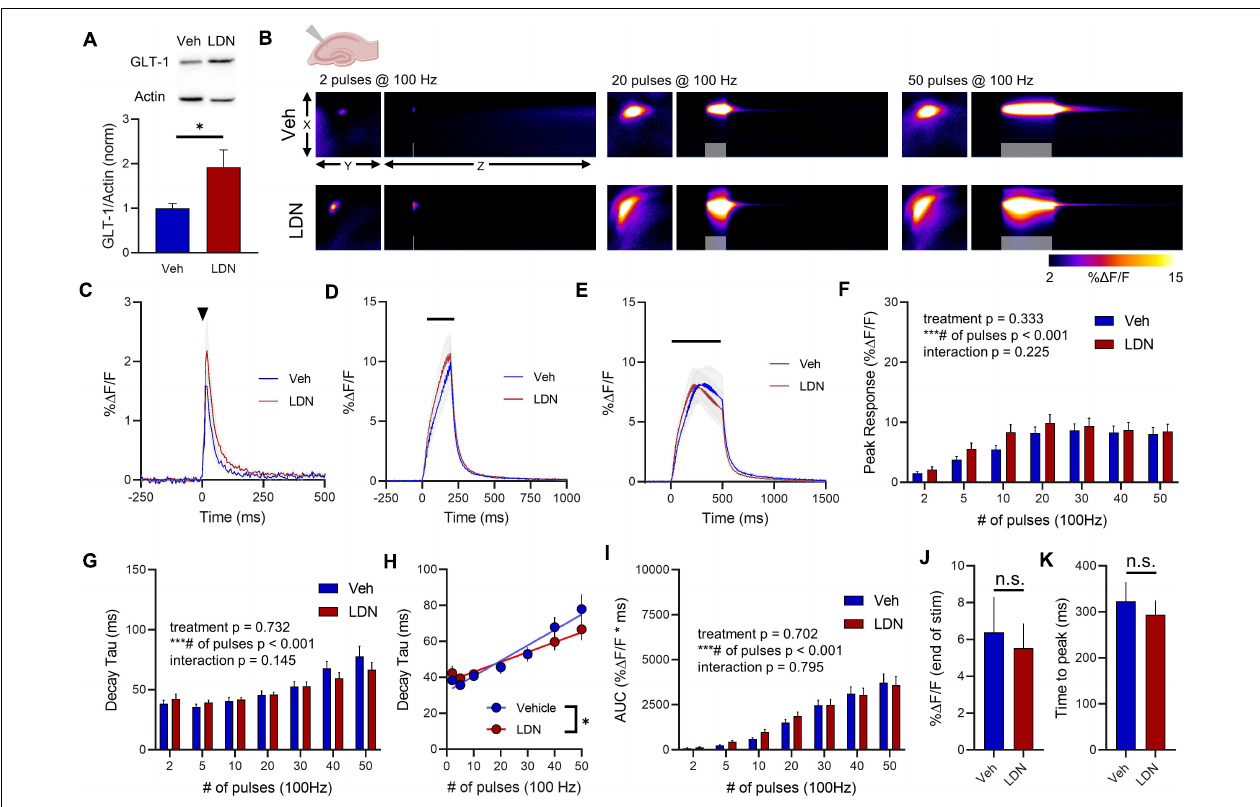
FIGURE 5 | The effect of LDN on glutamate dynamics in the hippocampus. (A) GLT-1 expression in hippocampal tissue from vehicle (Veh)- and LDN-treated mice. (B) Representative images depicting the iGluSnFR response evoked by 2 (left), 20 (middle), and 50 (right) pulses of electrical stimulation at 100 Hz in Veh- (top) and LDN-treated (bottom) mice. X–Y images (2048 × 2048 µ m) depict the maximal projection image of the iGluSnFR response, while the X–Z image (2048 µ m vertically x 1945 ms horizontally) depicts the iGluSnFR response over time (z-axis). Gray shading indicates the onset and duration of electrical stimulation at 100 Hz. (C–E) Mean ( ± S.E.M in gray) iGluSnFR responses to 2 (C) , 20 (D) , and 50 (E) pulses at 100 Hz in Veh- and LDN-treated mice. Electrical stimulation is denoted by the arrowhead in (C) and the horizontal lines in (D) and (E) . (F) Mean ( ± S.E.M) iGluSnFR response peaks. (G) Mean ( ± S.E.M) iGluSnFR decay tau values. (H) Linear regression to assess the magnitude of the activity-dependent increase in iGluSnFR decay tau. (I) Mean ( ± S.E.M) iGluSnFR area under the curve (AUC). (J) Mean ( ± S.E.M) of the iGluSnFR response size (% (cid:49) F/F) at the termination of the 50-pulse stimulation paradigm (50 pulses at 100 Hz). (K) Mean ( ± S.E.M) of the time required for the iGluSnFR response to reach a peak during the 50-pulse stimulation paradigm. ∗ p < 0.05, ∗∗∗ p < 0.001. n.s. not significant. Brain slice schematic in (B) was created using